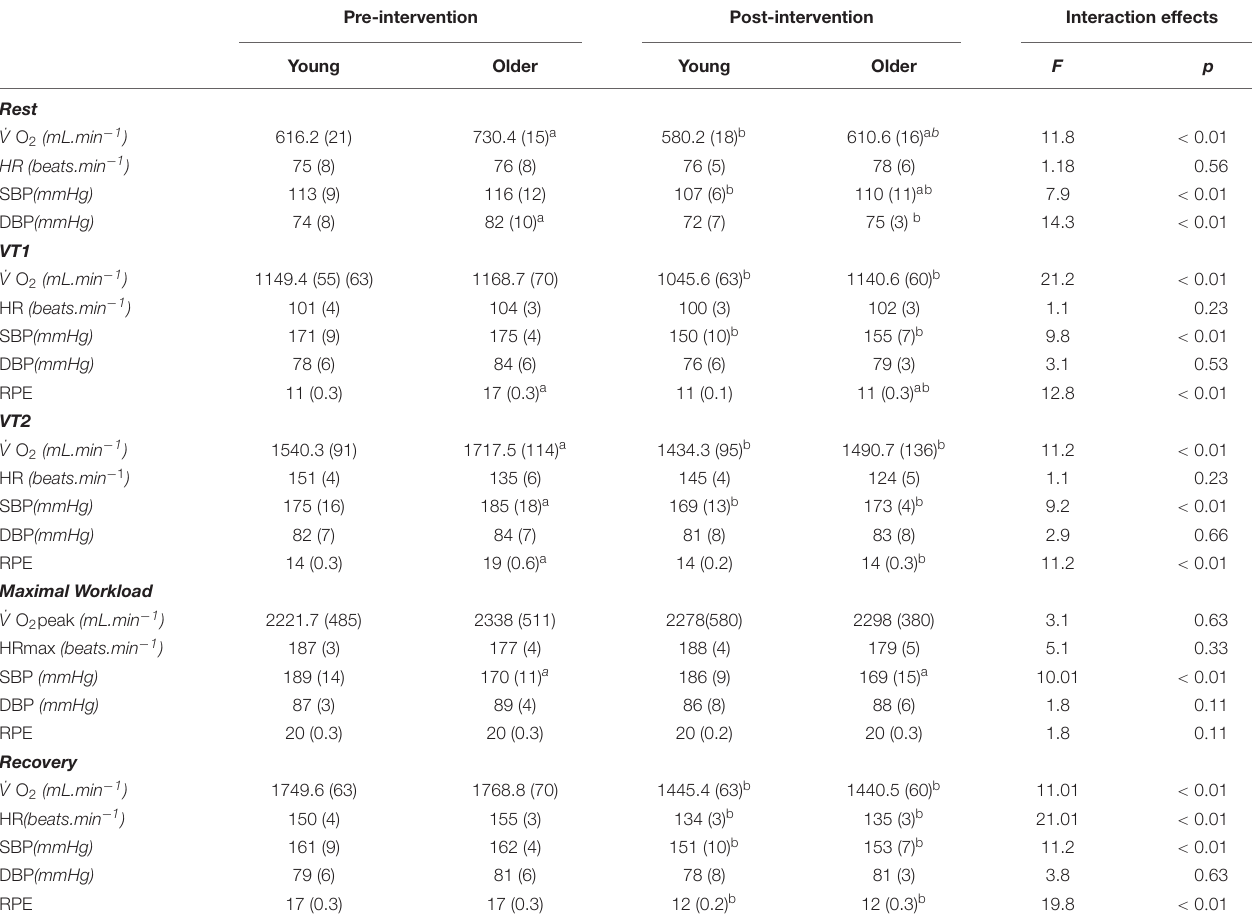
TABLE 3 | ANOVA results for the intervention × group interaction effects on physiological and perceptual data analyzed at rest, during the first and second ventilator thresholds (VT1 and VT2), at maximal workload and 10 min after the end of the test (recovery). Pre-intervention Post-intervention Interaction effects Young Older